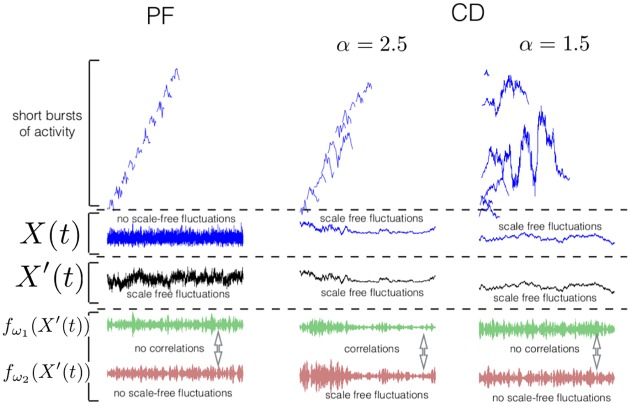
Illustration of the theory.Samples according to PF (left) and CD with the lifetime exponent α = 2.5, 1.5 and height exponent β = 1 (centre, right). Top row: avalanches ai,s(t) composing the continuous network signal X(t) by linear superposition (many avalanches superimposed over one another). Second row: continuous signal X(t). Third row: measured signal, filtered in the case of the PF theory (left) and a scalar multiple of the network signal X(t) in the CD case (centre, right). Fourth and fifth rows: narrowband signals at two frequencies ω1 and ω2. We observe that in all cases the observed signal X′(t) fluctuates over a range of time-scales. However the narrowband signals display pronounced fluctuations in their amplitude envelopes only in the CD model for certain exponent values. See Section: Results: Overview of Theory for a detailed description of each panel.